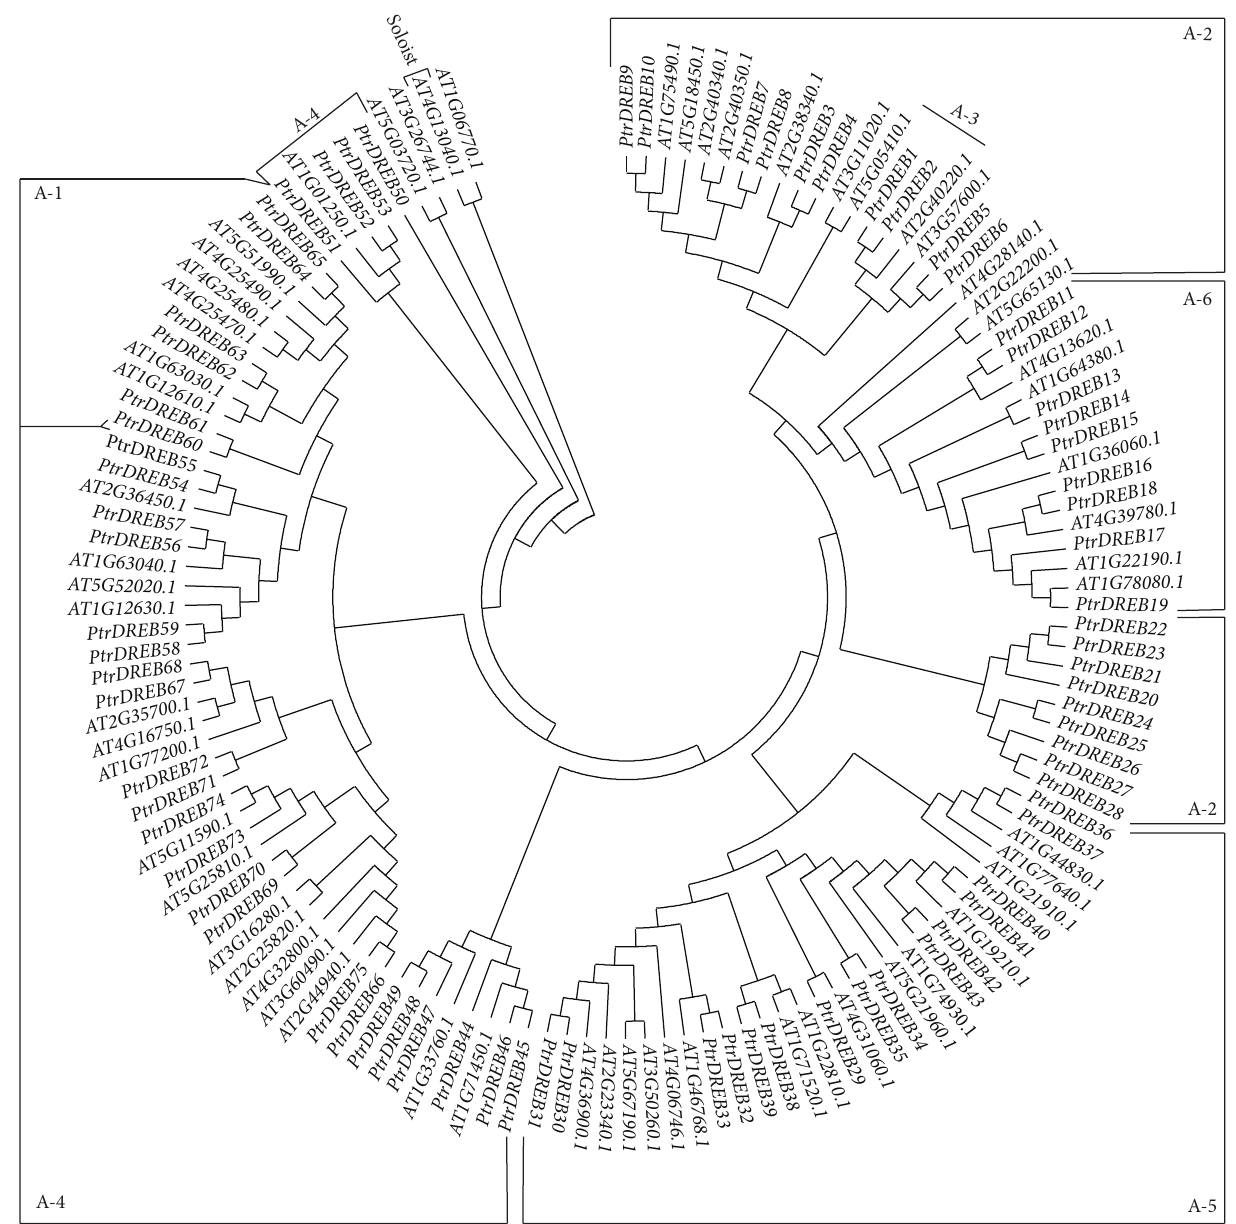
Figure 2: Relationships among Populus DREBs proteins after alignment with ClustalW. Proteins were allocated to six distinct subgroups of DREB , A-1 to